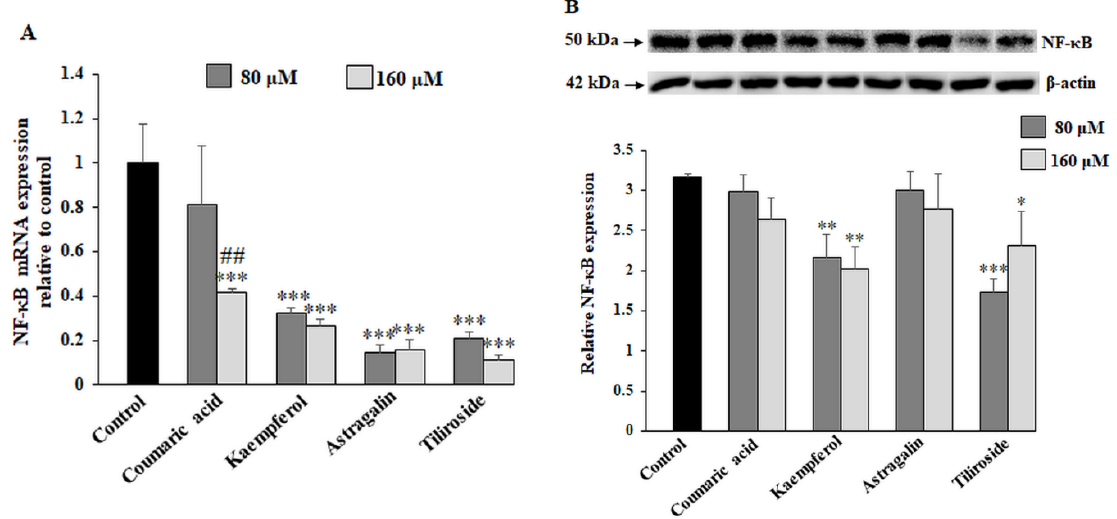
Figure 7. The effect of coumaric acid, kaempferol, astragalin and tiliroside on NF-κB mRNA and protein. The AGS cancer cells were incubated for 24 h with 80 and 160 µM concentrations of the polyphenolic compounds. mRNA was determined by RT-PCR ( A ). The results are shown as a relative fold change in mRNA expression of genes in comparison to the genes in control where expression was set at 1. ± SD are the mean of triplicate cultures. *** p ˂ 0.001 compared to untreated control; ## p ˂ 0.01 compared to lower concentration (80 µM) of specific polyphenolic. NF-κB protein expression was assessed by Western blot analysis ( B ). β-actin served as a protein loading control. The intensities of the bands were quantified by densitometric analysis. Data represent the mean ± SD of triplicate culture. * p ˂ 0.05, ** p ˂ 0.01, *** p ˂ 0.001 compared to untreated control. 3. Discussion It has been reported that many polyphenolic compounds exhibit anti-tumor functions by controlling cell viability or inducing apoptosis. Their application in cancer treatment gains attention due to their safety, efficiency and low side effects [12–18]. Altered glycosylation is also considered as a hallmark of carcinogenesis with involvement in the disease outcome [19]. Abnormal glycosylation is claimed to be a key factor of tumor malignant transformation and is closely related to the biological behaviors of tumor cells, such as growth, proliferation, migration and invasion [13,20]. However, because of the complexity and heterogeneity of glycan structures, full understanding of the role protein glycosylation in carcinogenesis remains a big challenge in the field. Thus, due to the limited studies concerning the effects of polyphenolics on glycosylation processes, we decided to evaluate the influence of selected polyphenolic compounds on such events in AGS gastric cancer cells. Coumaric acid, kaempferol, astragalin and tiliroside were involved in the study. p -Coumaric acid (4-hydroxycinnamic acid) (Figure 1A) is phenolic acid found ubiquitously in plants and mushrooms, in free or bound forms, revealing various bioactivities, including anti-cancer property. It can be subsequently transformed to other flavonoids [14]. Kaempferol (Figure 1B), a flavonoid widely present in many fruits, vegetables and traditional herbal medicines, has been reported as a cancer therapeutic agent by its anti-proliferative action, promoting autophagy and apoptosis [15,16]. Astragalin (kaempferol-3- O -β-D-glucoside) (Figure 1C), another naturally occurring flavonoid, polyphenolic compound, was demonstrated to induce cell death and inhibit proliferation and migration of cancer cells [17]. The last flavonoid examined in this study was tiliroside (kaempferol-3-β-D-(6’’- O - p -coumaroyl)-glucopyranoside) (Figure 1D), with anti-cancer potential revealed by affecting apoptosis and metastasis of cancer cells [18,21]. As mentioned above, pointing out aberrant glycosylation as a therapeutic destination in cancer therapy seems to be a promising strategy. The main glycoprotein of gastric epithelium is MUC1 mucin. Its overexpression and specifically altered glycosylation have